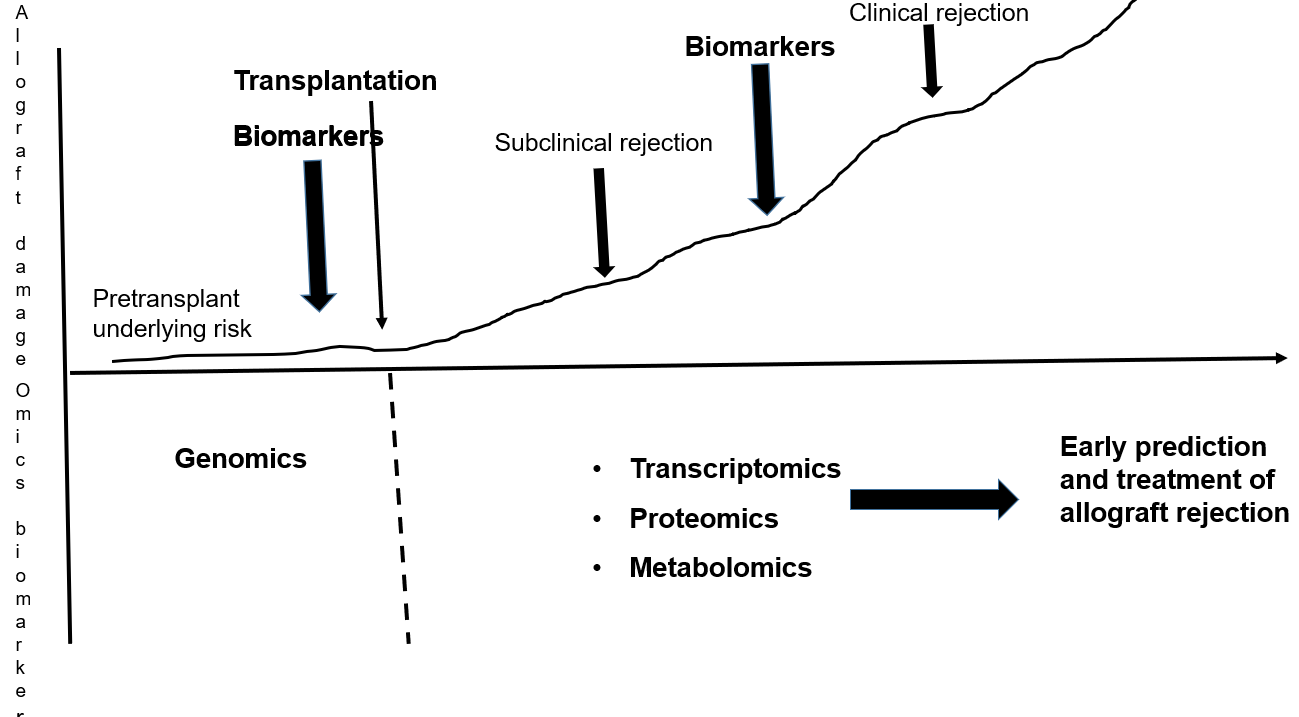
Figure 1. Evolution of a kidney allograft; role of biomarkers and technologies used